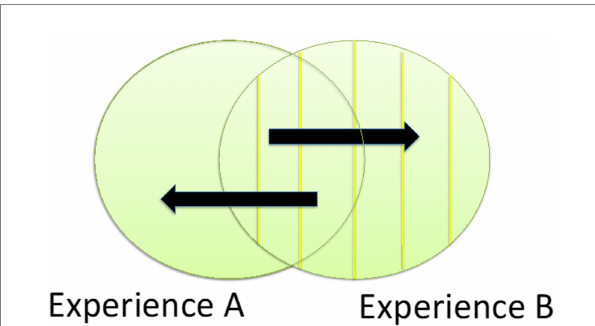
FIGURE 1 Association by similarity as process underpinning the individuation of experiences [adapted from Figure 3 in Vincini (2020)]. The two circles represent two experiences, or components of the flow of experience, and the overlap between the two circles represents what the two experiences have in common. In reference to the example of seeing two red stains on the wall, the picture highlights that while the stains on the wall do not overlap, the experiences presenting them do. At the level of the neural processes underpinning the distinct experiences, it is often legitimate to hypothesize that there is a quite literal kind of overlap (Gonzalez-Castillo et al., 2012; Barrett, 2017). As Barrett (2017, pp. 19–23) puts it, “a single brain area or network contributes to many different mental states. […] [T]he same neurons can participate in creating different mental states.” Then, the arrows moving from the overlap area to the non-overlap areas symbolize the process of reciprocal facilitation between the overlapping neural processes. In the examples from Stein (2000) and Carr (1986a) mentioned above, the individuation of an experience is connected with the individuation of the intentional object of the experience. Nevertheless, the functioning of associative links in the individuation of both the intentional object and the experience should not obscure the idea that the individuation of an intentional object and the individuation of an experience are structurally different kinds of phenomena—as emphasized by Vincini